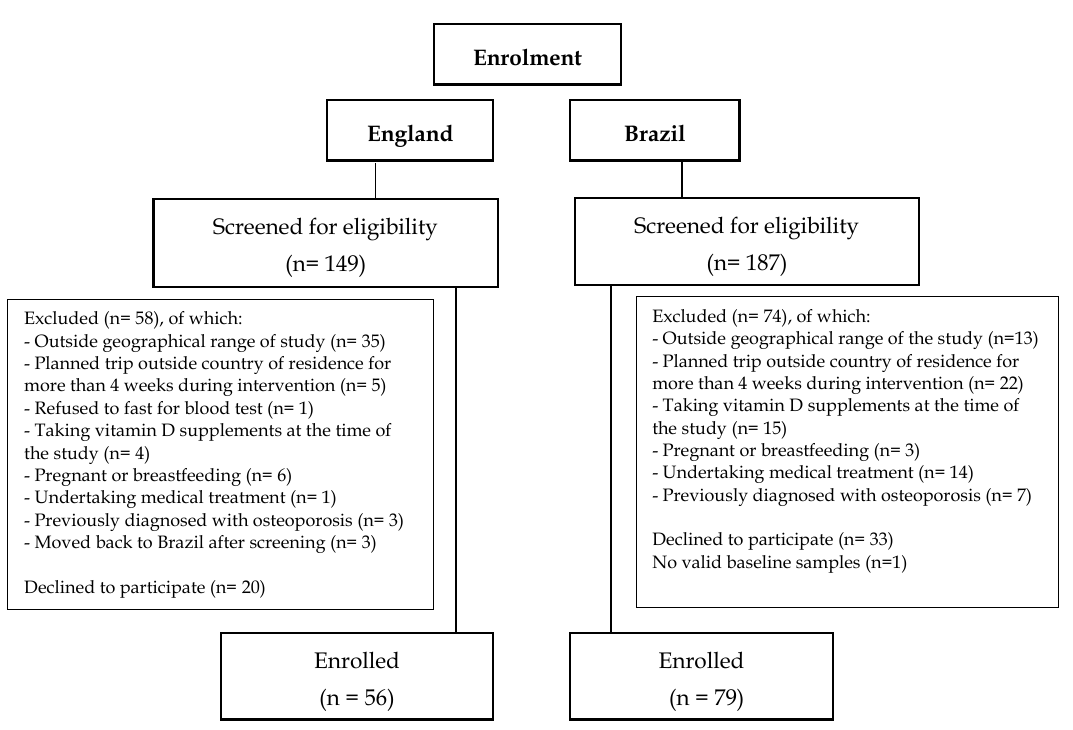
Figure 1. Flow diagram of participant enrolment.